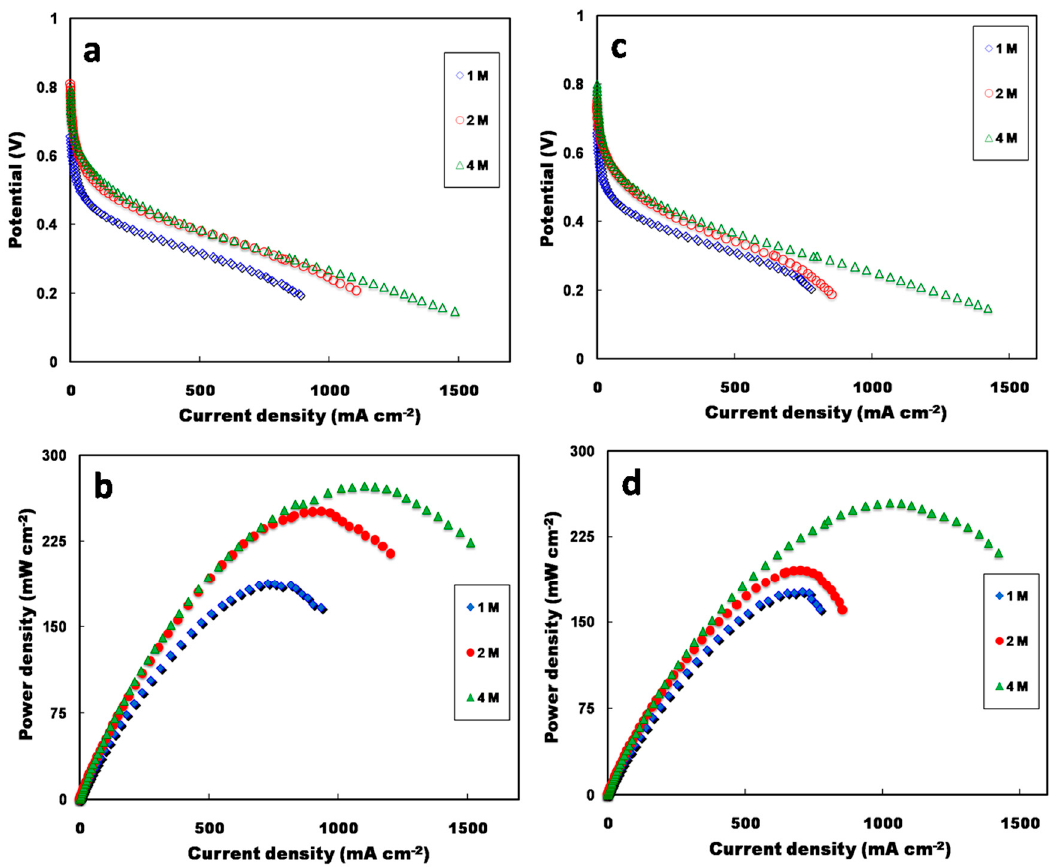
Figure 8. Effect of different concentrations of methanol feed on DAMFCs performance using KOH-doped nanocomposite electrolyte: ( a ) cell voltage; and ( b ) power density using QPVA/CTAB-coated LaFeO 3 as an electrolyte; ( c ) cell voltage; and ( d ) power density using QPVA/annealed LaFeO 3 as an electrolyte (cell temperature of 60 °C).